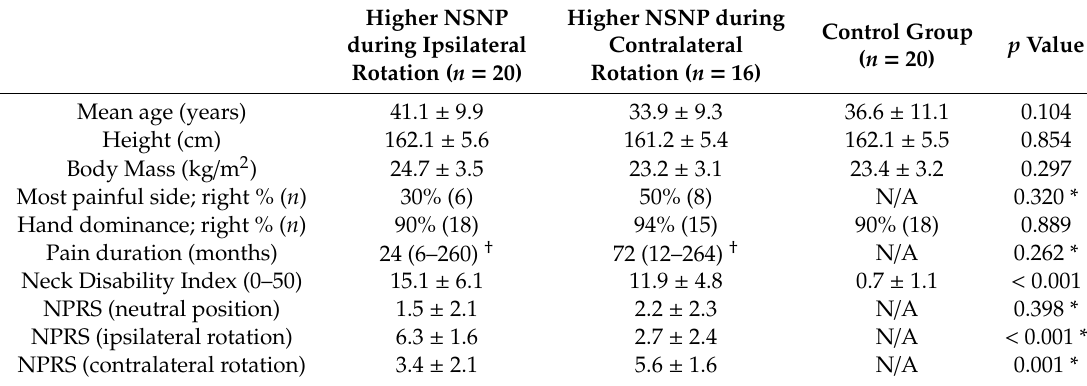
Table 1. Clinical and demographic characteristics of participants (mean ± standard deviation or in frequency